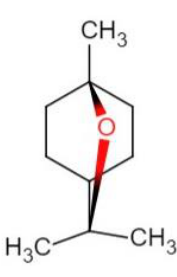
Figure 1. The chemical structural formula of